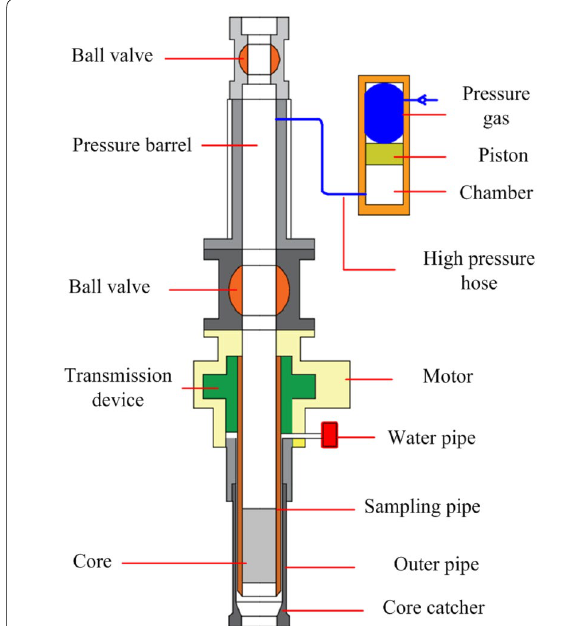
Figure 7 Schematic of the manipulator holding pressure and insulation corer